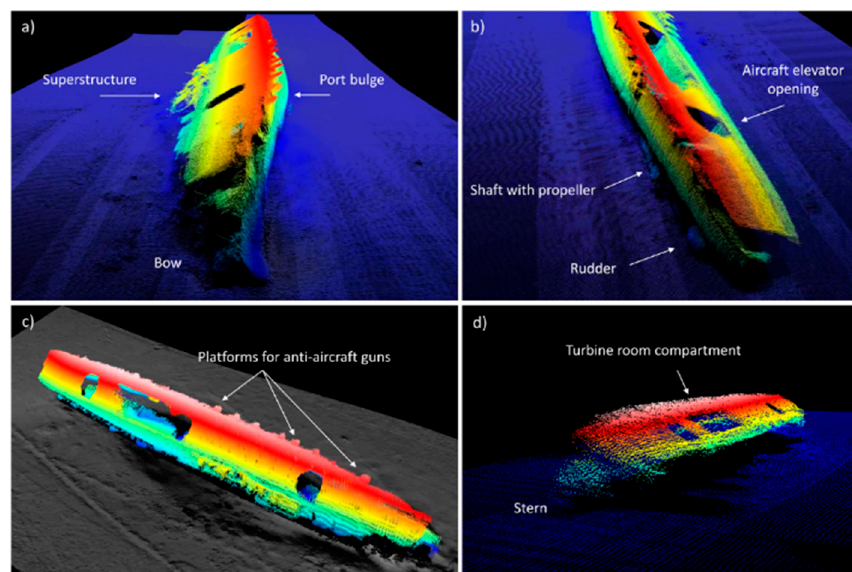
Figure 14. Digital terrain models of the aircraft carrier shipwreck Graf Zeppelin derived from MBES data. ( a-d ) digital models viewed from different angles